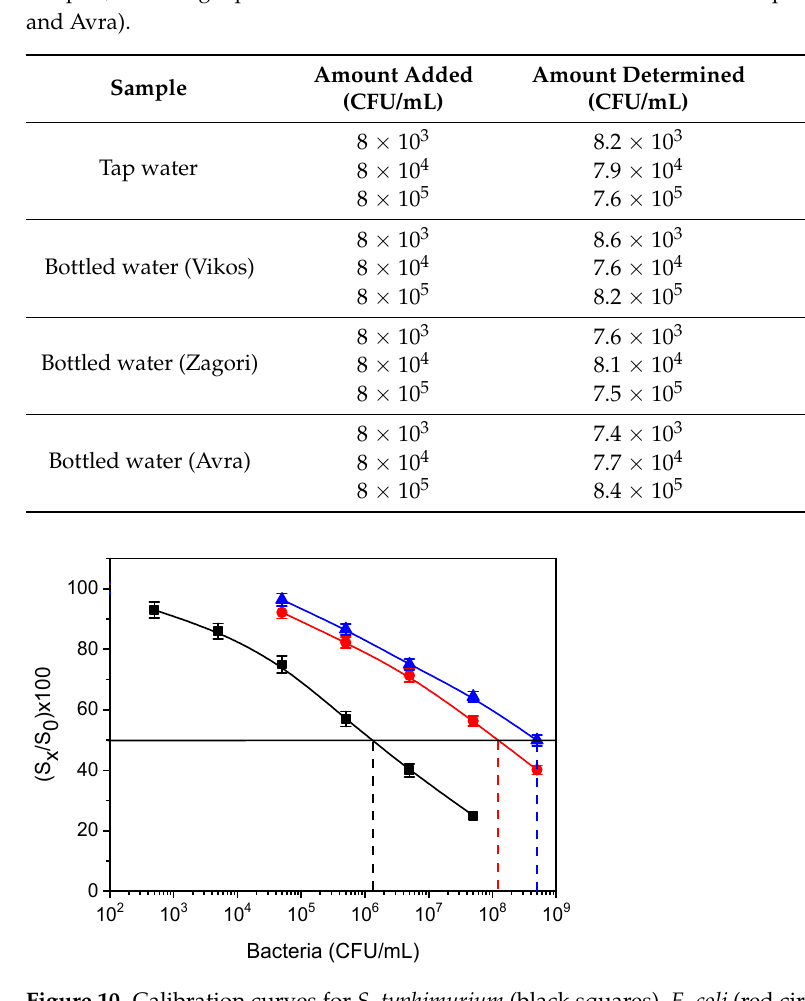
Figure 10. Calibration curves for S. typhimurium (black squares), E. coli (red circles), and S. thomson (blue triangles) obtained from LPS-coated WLRS chips. The dashed vertical lines indicate the bacteria concentration that corresponds to a 50% signal drop with respect to zero calibrator (horizontal black line). Each point is the mean value of the signals obtained from three chips ± SD.